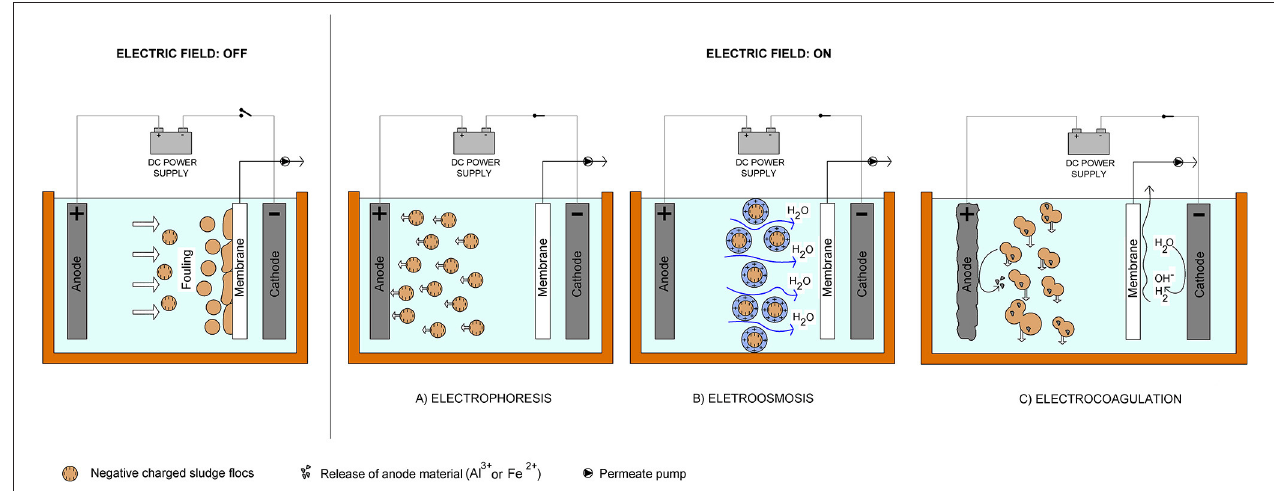
FIGURE 1 | Electrochemical mechanisms occurring in the operation of the electro MBR (eMBR): (A) electrophoresis, (B) electroosmosis, (C)